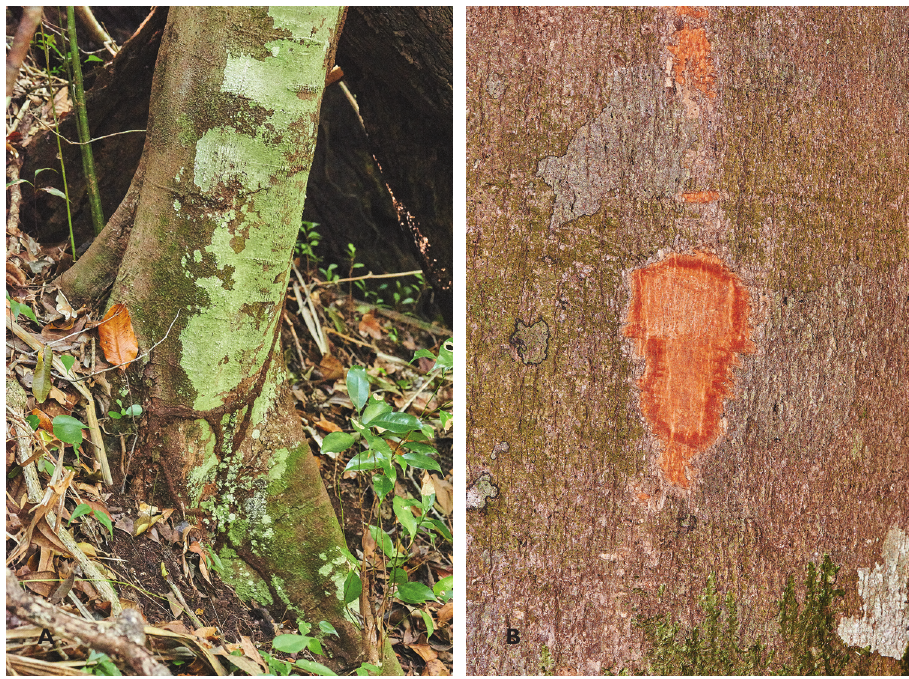
A Figure 2. A Lower trunk and buttress of Cinnamomum bladenense B Bark and shallow trunk slash. Photos of same individual tree as Brewer & Stott 7529 by SW Brewer 18 March 2014.